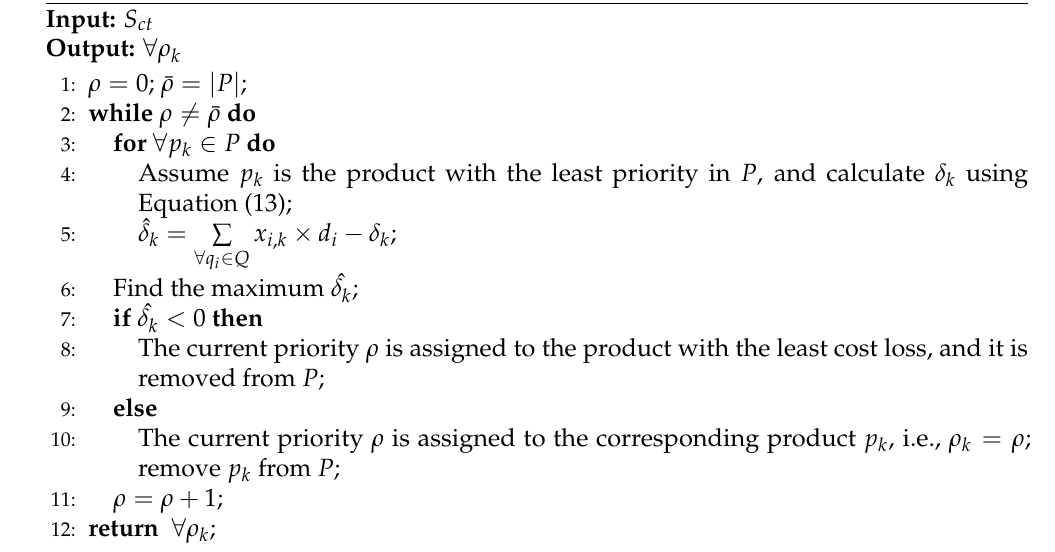
Algorithm 2 Priority assignment algorithm AssignPriority ()